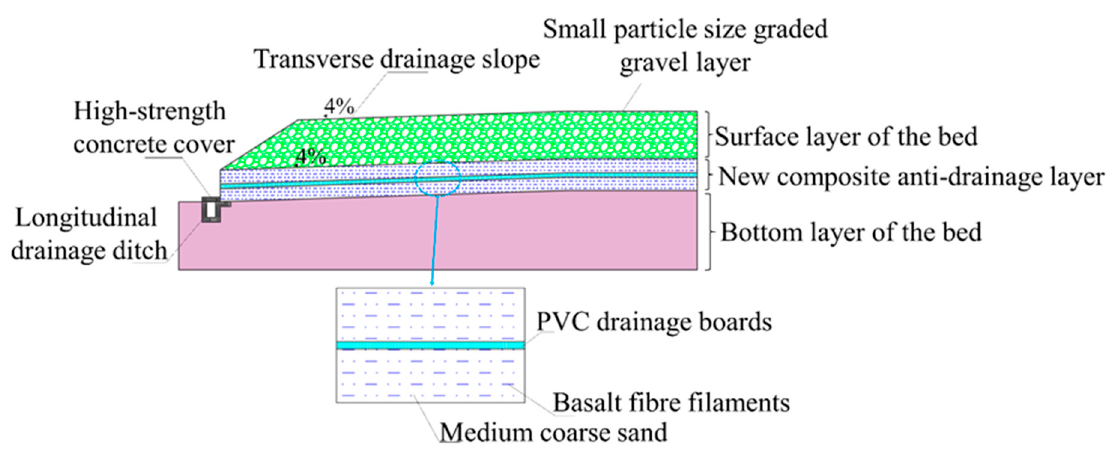
Figure 6. Diagram of the new antidrainage subgrade structure in the diatomaceous earth area.